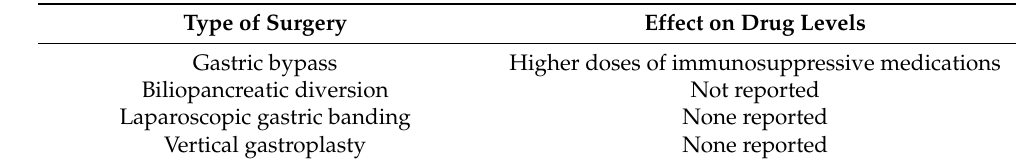
Table 1. Effect on Drug levels of bariatric surgeries